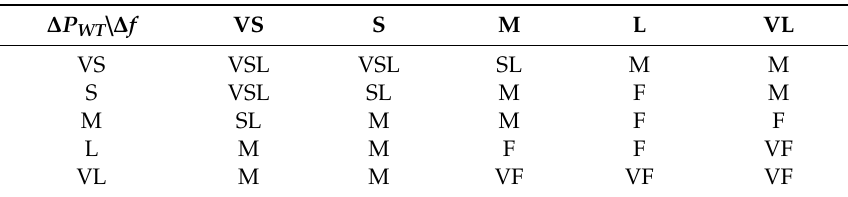
Table 1. Fuzzy inference